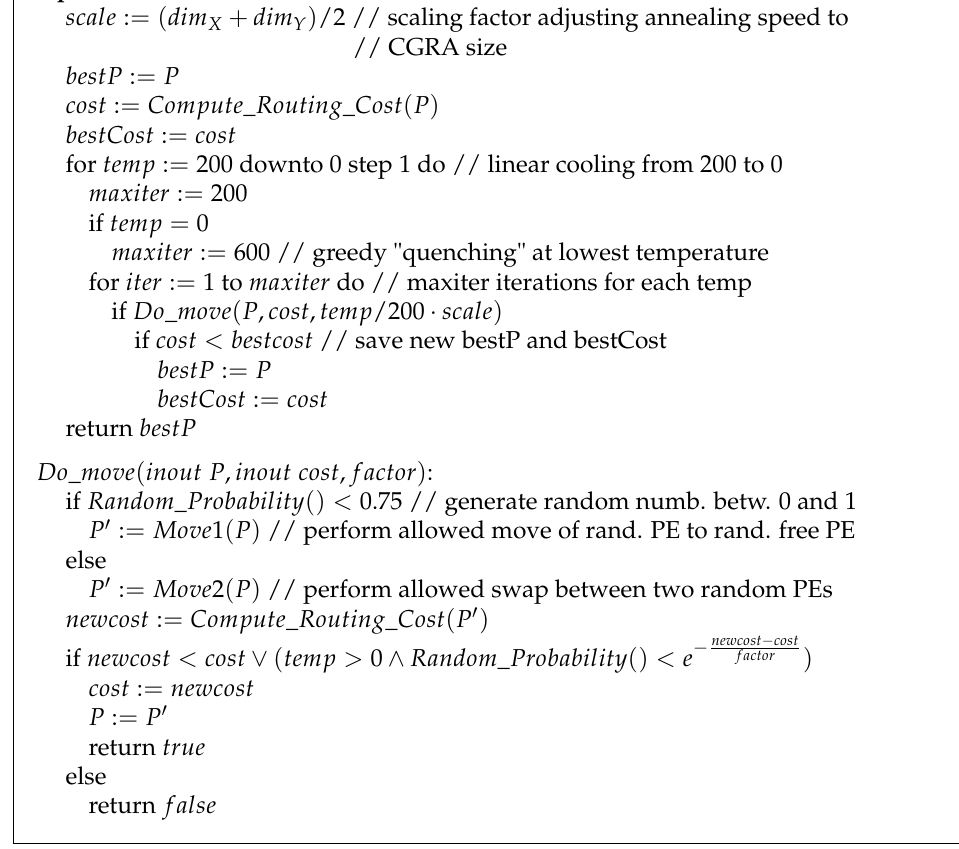
Figure 8. Simulated Annealing algorithm Optimize_PBR.